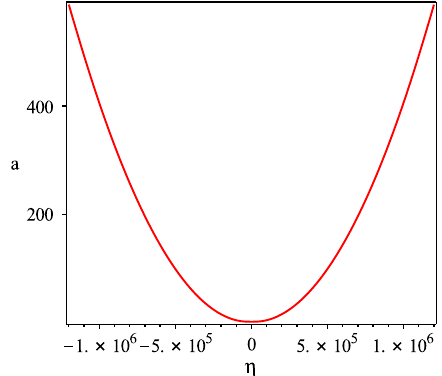
Fig. 1 The evolution of the scale factor versus η . At bounce point ( η = 0), it gives a positive non-zero